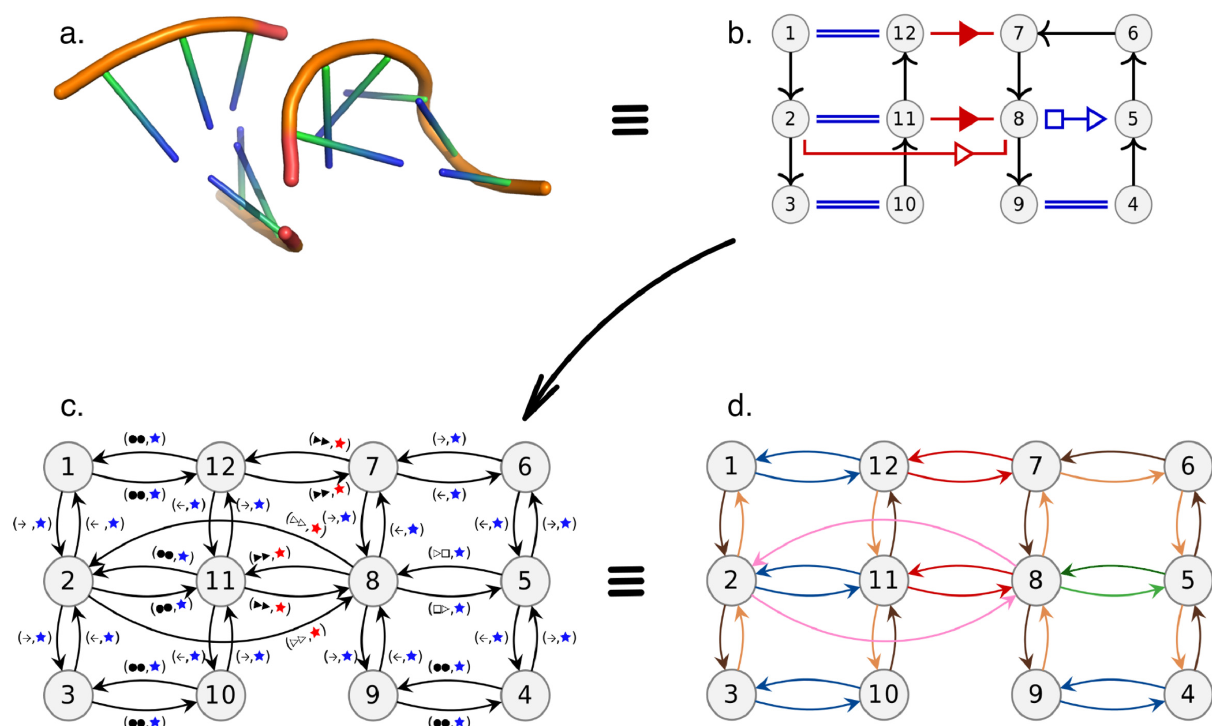
Fig 2. From 3D structure to directed edge-labelled graph. In this figure we illustrate the transition from the 3D structure (a) to RNA 2D structure graph (b) and finally directed edge-labelled graph (c) with a simple RNA structure. Each edge label of the directed edge-labelled graph is a pair which first element represents the type of interaction (using the same symbols as in the RNA 2D structure graph) while the second denotes the local (blue) vs. long-range (red) property of the interaction (using the same colors as in the RNA 2D structure graph). Moreover, the set of edge labels forms a directed proper edge-coloring , as illustrated with the last panel (d) where each different geometric type of interaction has been associated a color. Note that panel (d) is only an illustration of the edge labels forming a proper edge-coloring as our method does not actually replace the labels by